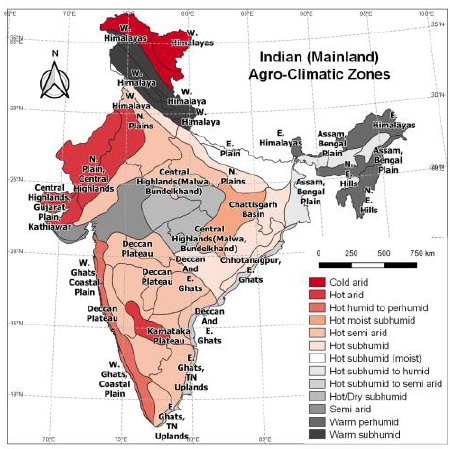
Figure 1: Study Area (Source: NBSSLUP)